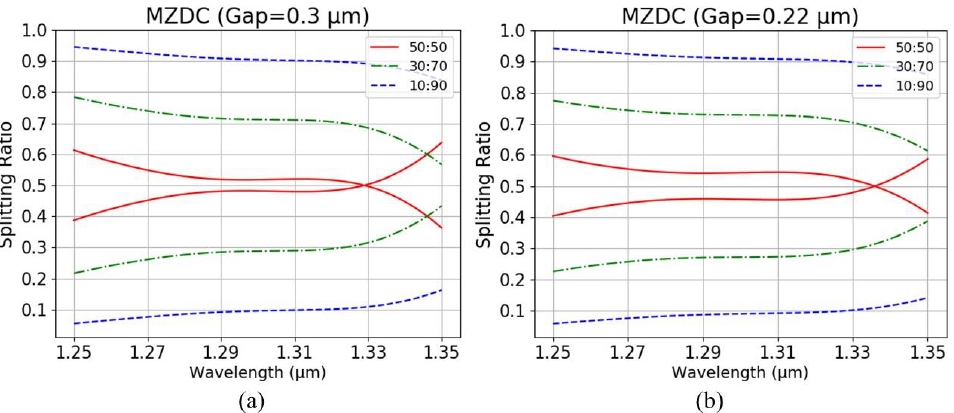
Figure 7. Excluding bend e ff ect of MZDC with gap ( a ) 0.3 µ m and ( b ) 0.22 µ